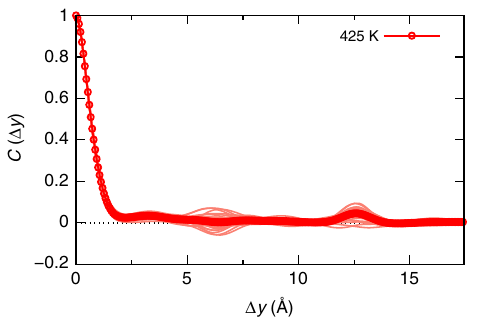
Fig. 7 Characterization of the disorder potential for electronic states in MAPbI 3 . Autocorrelation function of the disorder potential, where the thin curves show sample snapshots taken along the force- fi eld MD trajectory, and the thick curves shows their average. The disorder potential in MAPbI 3 is also con fi ned to very short ranges